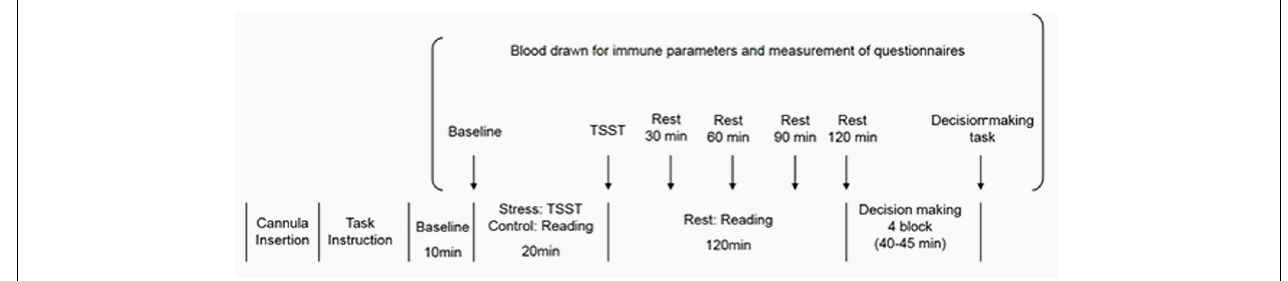
FIGURE 2 | Experimental protocol of the present